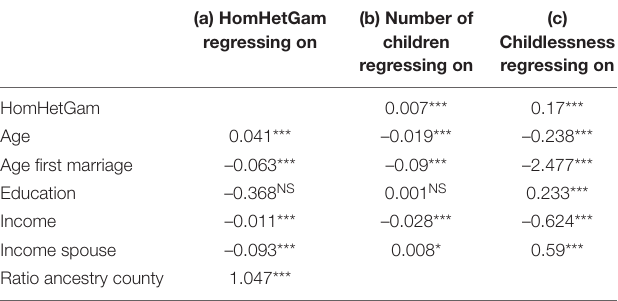
TABLE 8 | General linear mixed model of (a) HomHetGam regressing on age, age at first marriage, education, income, the income of the spouse, and the ratio of the own ancestry group in a county on the basis of a binomial error structure and (b) the number of children, and (c) childlessness regressing on HomHetGam, age, age at first marriage, education, income, and the income of spouses on the basis of a Poisson error structure, respectively, a binomial error structure, with ancestry as a random factor; excluding all individuals not born in the United States.